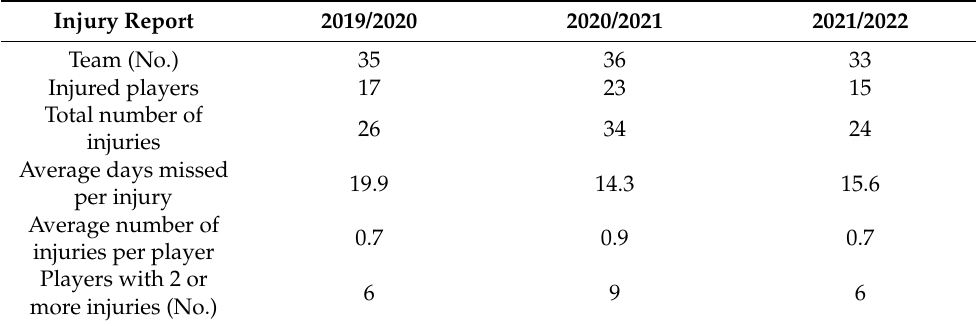
Table 2. Injuries reported during three consecutive sporting seasons.